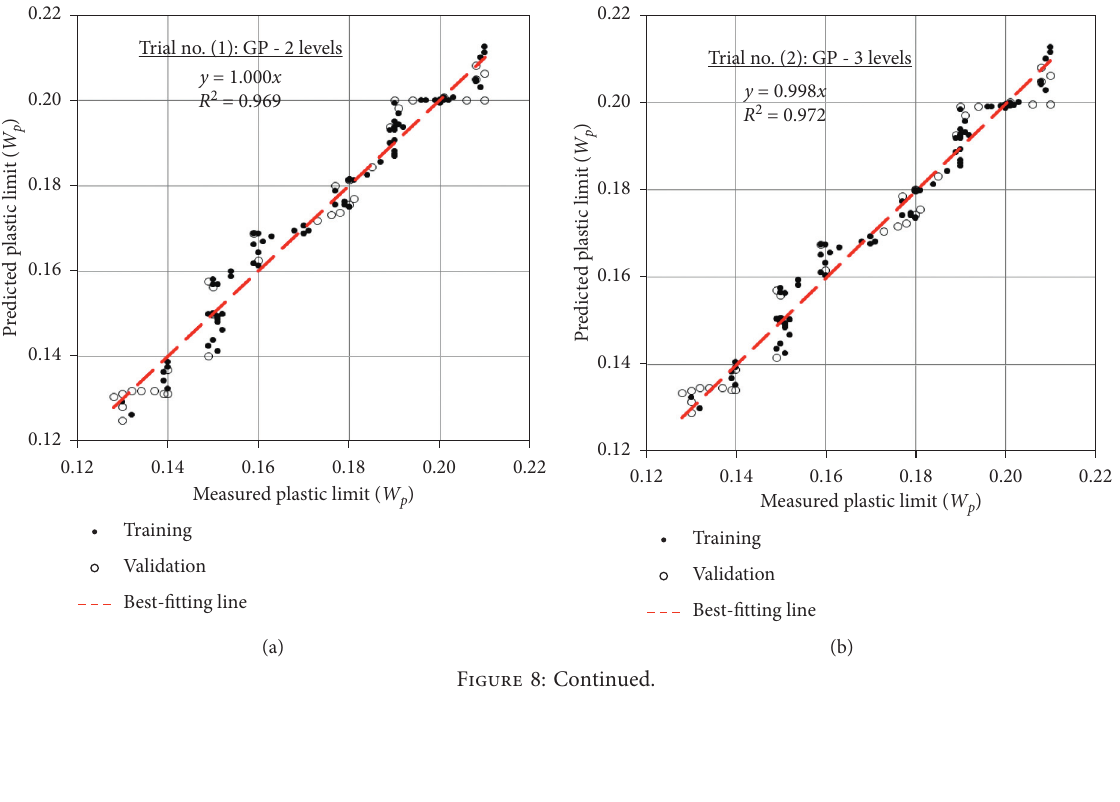
L ) values using the developed GP and ANN